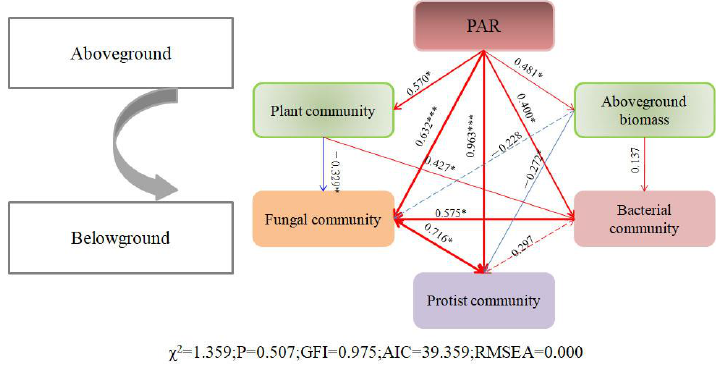
Figure 11. The structural equation model shows the relationship among PAR, aboveground plant community, and belowground microbial communities. The solid and dotted arrows indicate sig- nificant and non-significant correlations, respectively. The numbers above the arrow indicate the path coefficient. The width of the arrow is positively correlated with the path coefficient. Red and green indicate positive correlation and negative correlation, respectively. Significance levels are denoted with * p < 0.05, ** p < 0.01, *** p < 0.001.